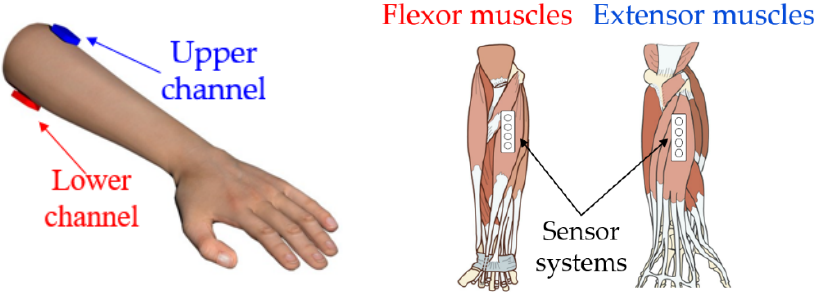
Figure 7. The location of the sensors systems in the projection of the